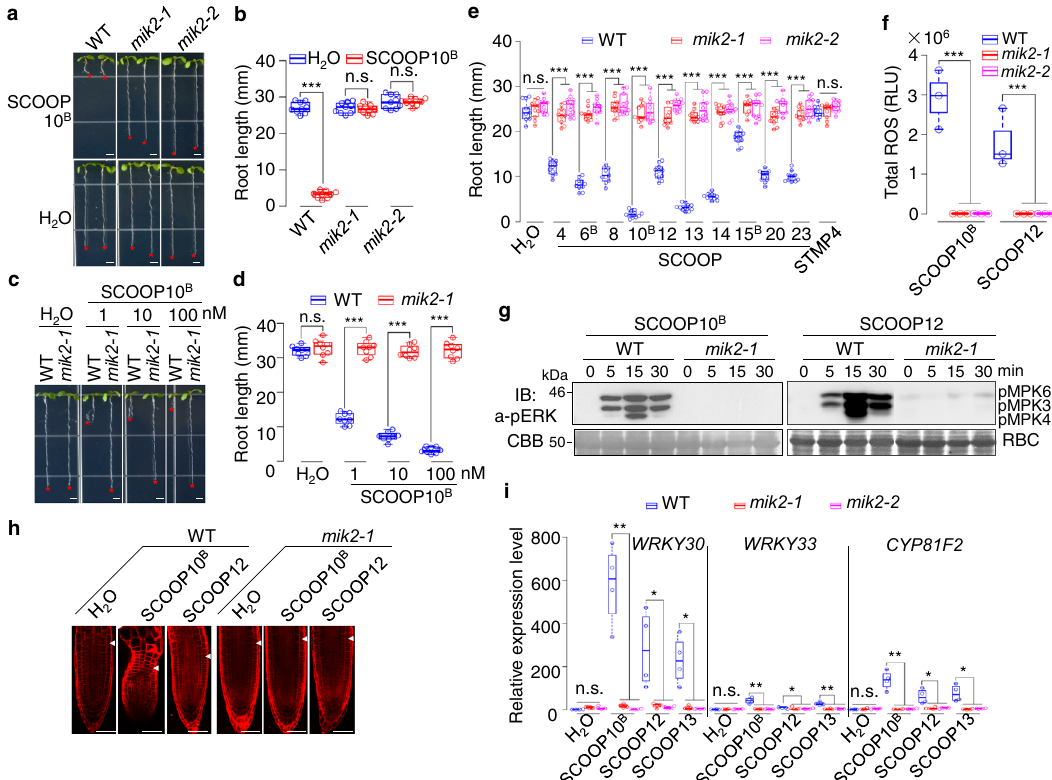
Fig. 3 SCOOP-triggered responses depend on MIK2. a – d SCOOP10 B -triggered root growth inhibition is blocked in mik2 mutants. Images of 10-day-old WT and mik2 mutant seedlings with or without 1 µ M SCOOP10 B ( a ) or different concentrations of SCOOP10 B ( c ). Quanti fi cation of root length of seedlings is shown ( b , d ) (*** P < 0.001, n.s., no signi fi cant differences, two-tailed Student ’ s t -test, n = 9 in ( b ), n = 8 in ( d )). Scale bar, 4 mm. e The mik2 mutants block the root growth inhibition induced by different SCOOPs. Quanti fi cation of root length of 10-day-old WT and mik2 seedlings with or without 1 µ M SCOOPs (*** P < 0.001, n.s., no signi fi cant differences, two-tailed Student ’ s t -test, n = 9, plots 1 – 3, 5, 8 – 10, 12, 22 – 24, 27, 29, 31, 32, 36; n = 10, plots 4, 6, 7, 11, 15, 16, 18, 19, 21, 25, 30, 33; n = 8, plots 14, 17, 20, 26, 34, 35). f SCOOP12-induced ROS production is blocked in mik2 mutants. One-week-old seedlings were treated with 100 nM SCOOP10 B or SCOOP12, and ROS production was calculated as total RLU (*** P < 0.001, two-tailed Student ’ s t -test, n = 3). g SCOOP10 B and SCOOP12-induced MAPK activation is blocked in mik2-1 . Ten-day-old seedlings were treated with or without 1 µ M SCOOP12. The MAPK activation was analyzed by immunoblotting (IB) with α -pERK1/2 antibodies. The protein loading is shown by CBB staining for RBC. h The mik2-1 mutant blocks SCOOP-induced root meristem distortion. Confocal images of root tips of 5-day-old seedlings with or without treatment of 1 µ M peptides for 48 h followed by PI staining. Arrowheads indicate the boundary of the root meristem and the elongation zone. Scale bar, 50 µ m. i SCOOP-induced defense gene expression is blocked in mik2 mutants. Ten-day-old seedlings were treated with or without 1 µ M SCOOP10 B , 12, or 13 for 1 h and subjected to RT-qPCR analysis. Expression of genes was normalized to that of UBQ10 (* P < 0.05, ** P < 0.01, n.s., no signi fi cant differences, two-tailed Student ’ s t -test, n = 4). The box plots in ( b ), ( d ), ( e ), ( f ), and ( i ) show the fi rst and third quartiles as bounds of box, split by the medians (lines), with whiskers extending 1.5-fold interquartile range beyond the box, and minima and maxima as error bar. The experiments in ( a – d ), ( f ), ( h ), and ( i ) were repeated three times, and ( e ) and ( g ) twice with similar